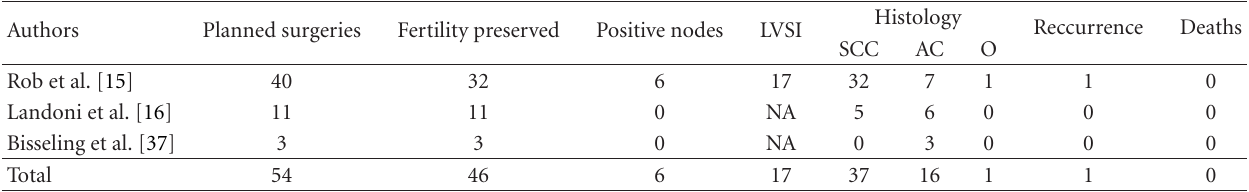
Table 6: Characteristics and oncological outcome for less radical